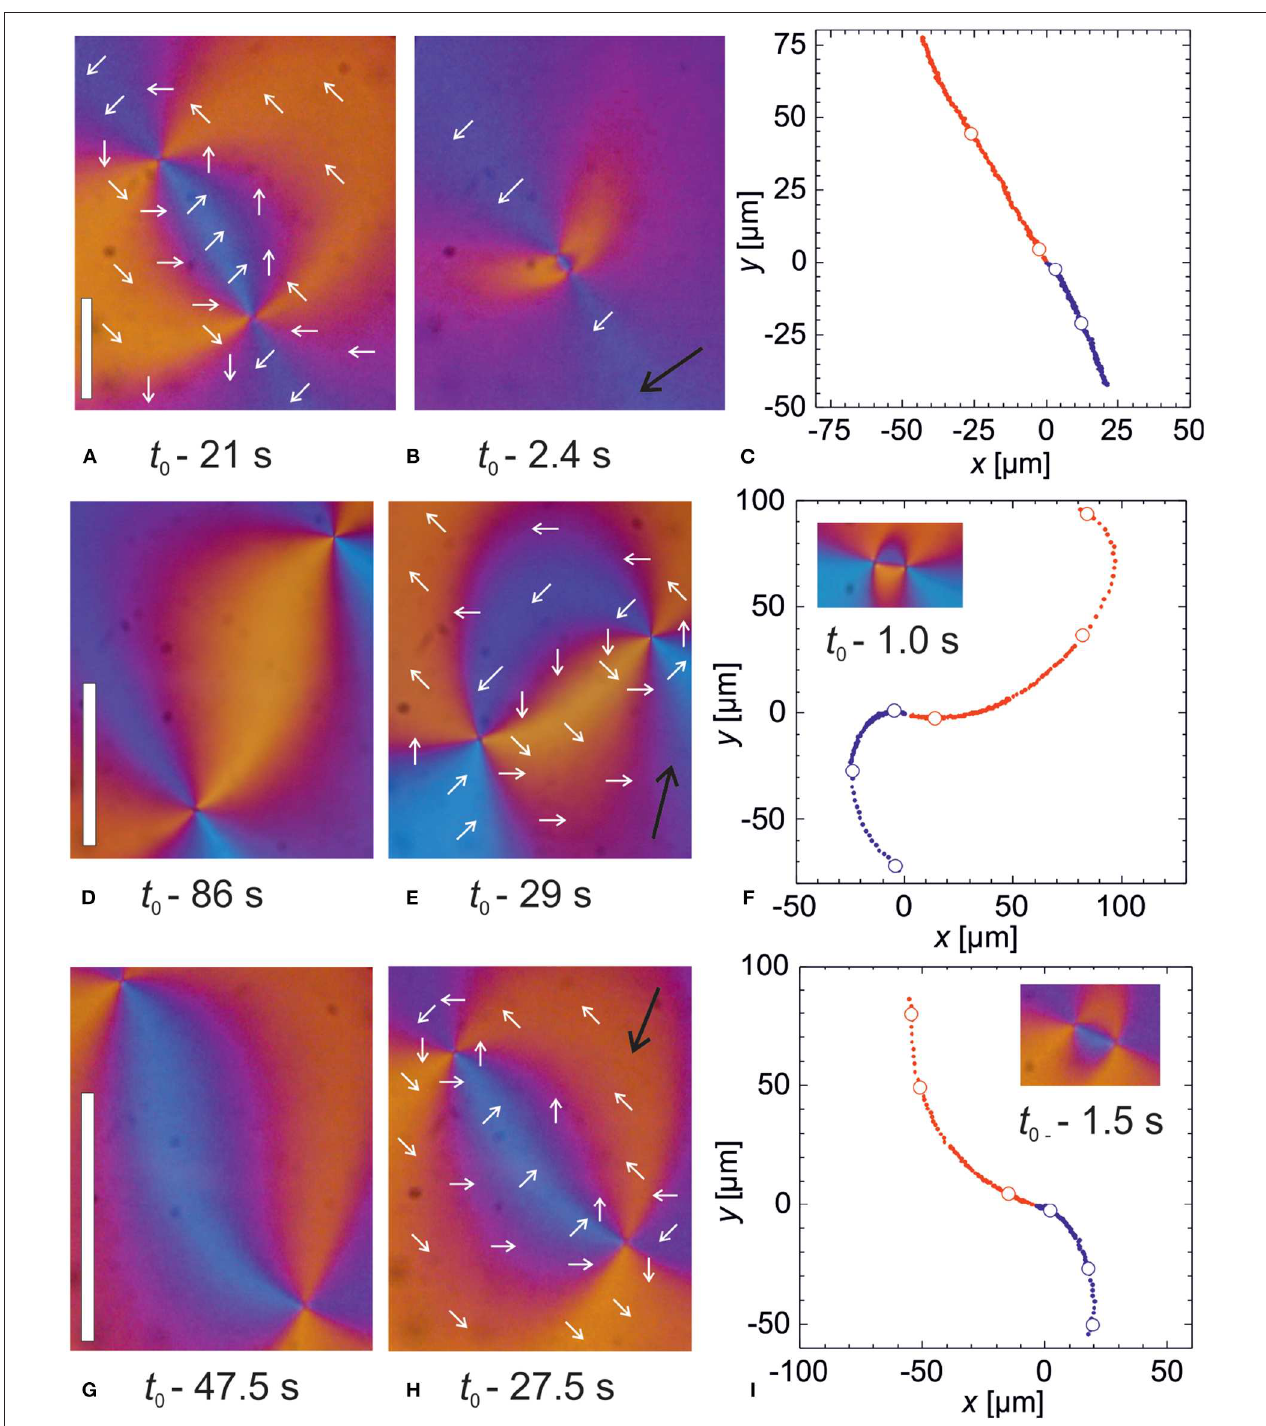
FIGURE 11 | (A–C) Matching defect pair, δθ 0, in perfect alignment, δφ 0. Times refer to the annihilation event, white circles in (C) mark the positions where (A,B) = = were recorded. (D–F) Same for mismatching, misaligned pair with initial angles δθ 65 ◦ , δφ 36 ◦ , (G–I) mismatching, misaligned pair with initial angles = + = − δθ 50 ◦ , δφ 79 ◦ . The white bar in (A) marks 50 µ m, in (D,G) 100 µ m. Black arrows indicate the orientation of the far director. Images reprinted from Missaoui = − = + et al. [43].